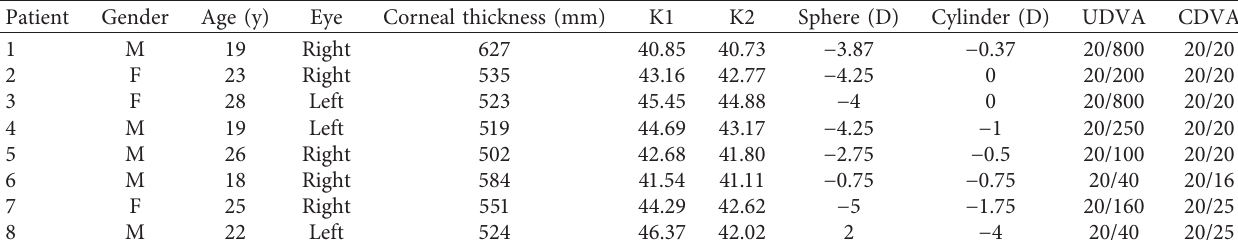
Table 1: Basic information of patients.